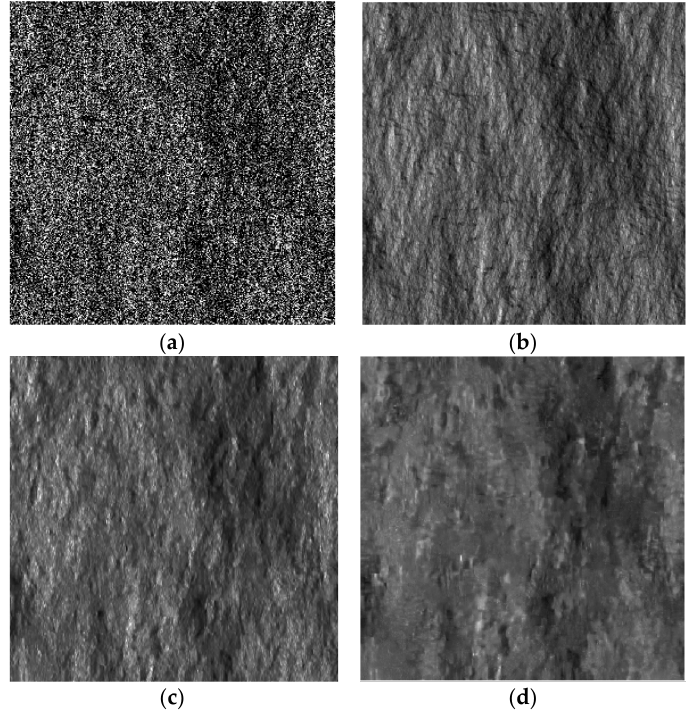
Figure 5. Simulated and despeckled SAR images relevant to the DEM in Figure 2a and assuming the cos (cid:2872) (cid:2036) scattering model. ( a ) Noisy; ( b ) reference SAR image; ( c ) SB-SARBM3D; ( d ) SARBM3D.